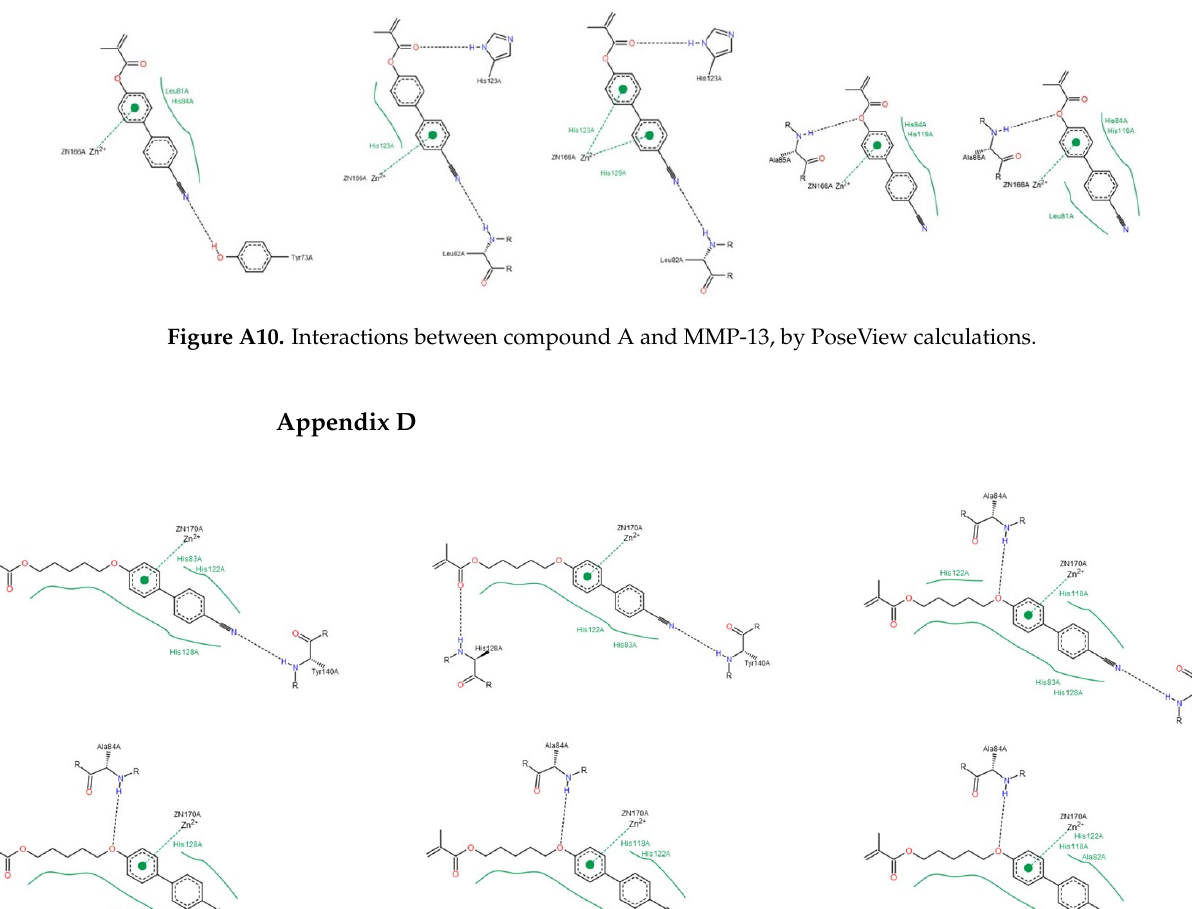
Figure A11. Interactions between compound B and MMP-1, by PoseView calculations.